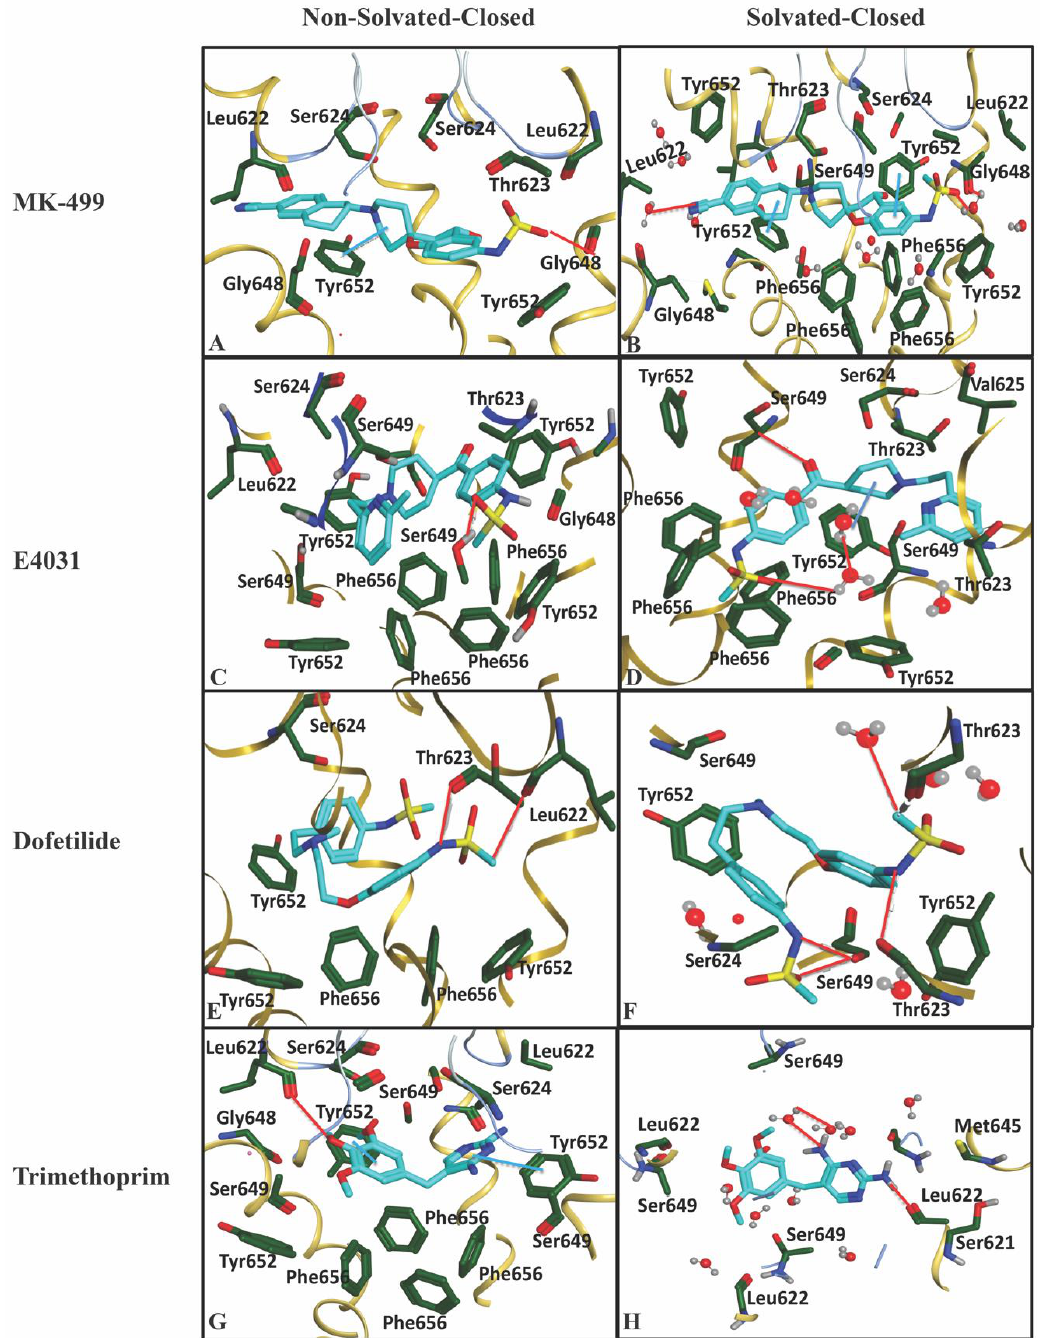
Figure 7. ( A ) Finally selected docked pose of Mk-499 in non-solvated closed binding cavity showing hydrogen bonding with Gly648 and π–π interactions with Tyr652. ( B ) MK-499 showing π–π interactions with Tyr652 and water mediated interactions with Gly648. ( C ) Selected docked conformation of E4031 in non-solvated cavity showed hydrogen bonding with Ser649. ( D ) E4031 in solvated cavity showed hydrogen bonding with Ser649 and oxygen of methanesulfonamide showed ligand–water and water–water hydrogen bond interactions. ( E ) Dofetilide showing hydrogen bonding with Thr623 and Leu622 in non-solvated-closed cavity. ( F ) Dofetilide final docked pose in solvated-closed binding cavity of hERG showing hydrogen bonding with Thr623 and Ser649 the ligand–water hydrogen bond is also observed. ( G ) Final docked pose of Trimethoprim in non-solvated cavity showing hydrogen bonding with Leu622 and π–π interactions with Tyr652. ( H ) Trimethoprim final pose docked in solvated binding cavity showed ligand–water and water–water hydrogen bond interaction with the nitrogen of the